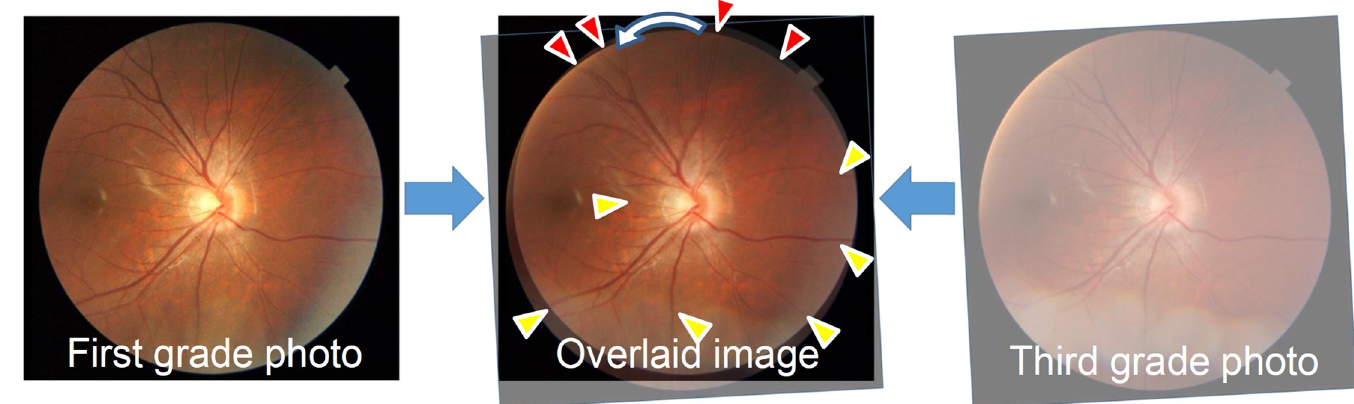
Fig 1. Assessment of the retinal vessel shift using fundus photographs of the subjects when in the first and third grades. Perfect matching in the temporal, inferior, and nasal vessels (yellow triangles) and mismatching (anticlockwise shift) in the superior vessels (red triangles).